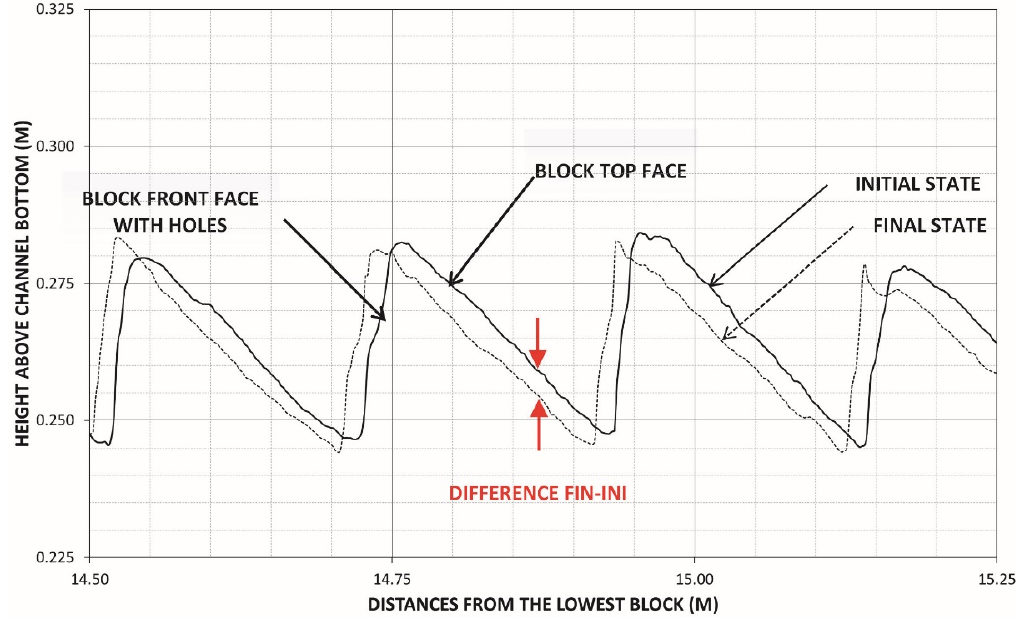
Figure 20. Detail of the longitudinal profile of the WSB armouring. The black dotted lines represent the final state, while the continuous black line represents the original state.